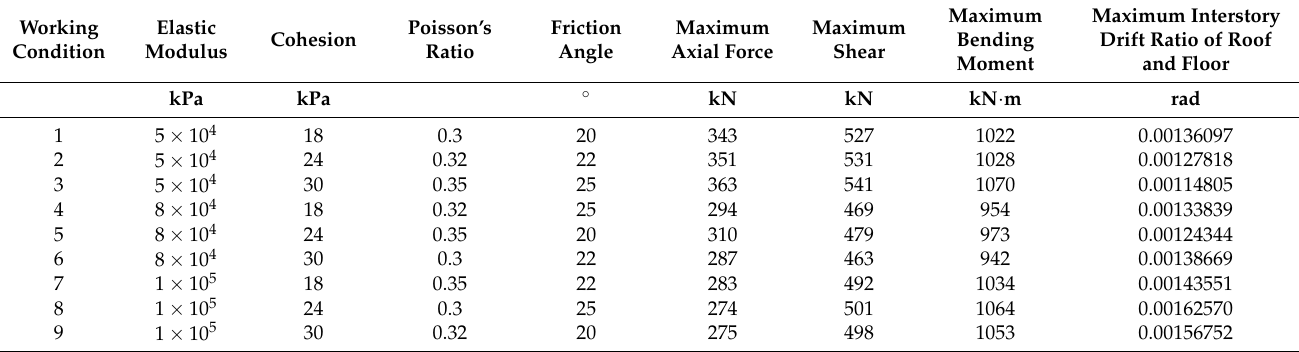
Table 4. Dynamic response values under a horizontal transverse earthquake.